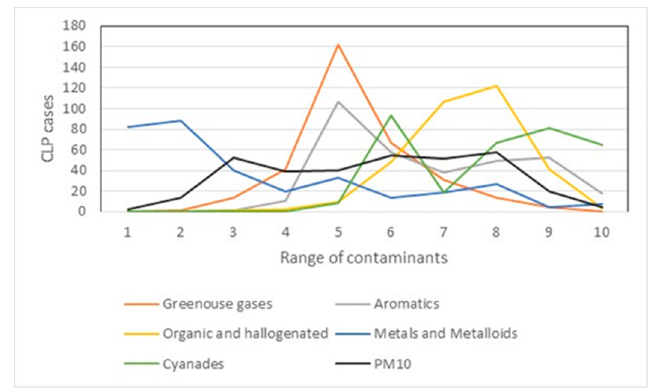
Figure 7. CLP cases by substance in different ranges of contamination.